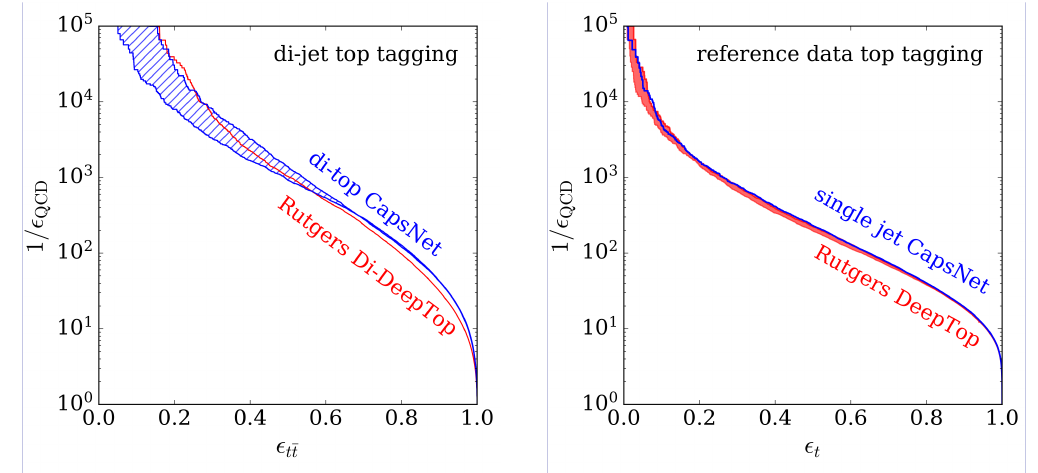
Figure 5: Left: comparison between CapsNet and the Rutgers D EEP T OP CNN for for the di-tops vs QCD di-jets. Right: same comparison for single top jets using a standard dataset [ 29 ] ∗